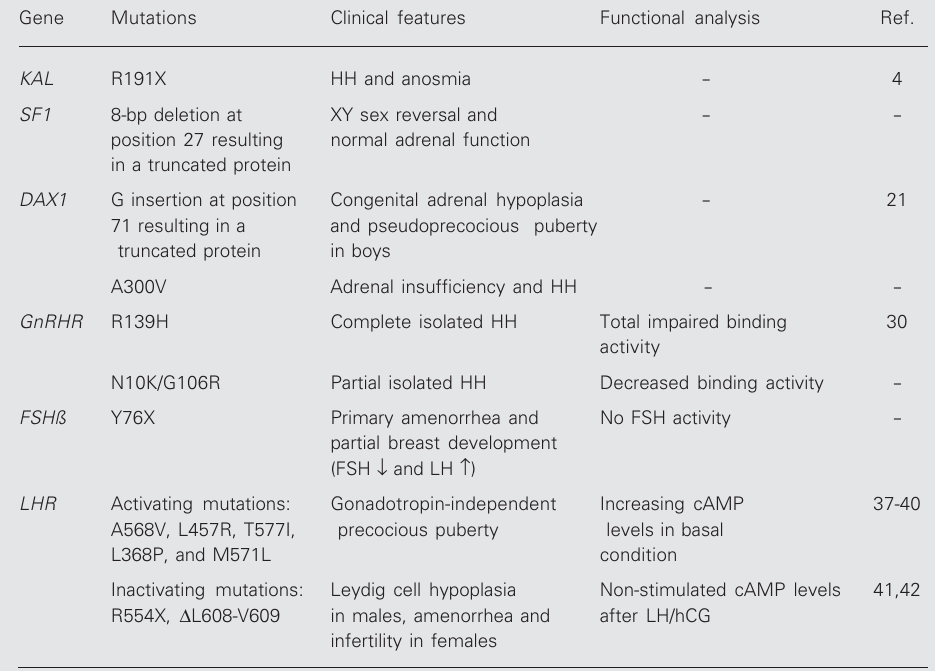
Table 2. Mutations identified in patients with reproductive